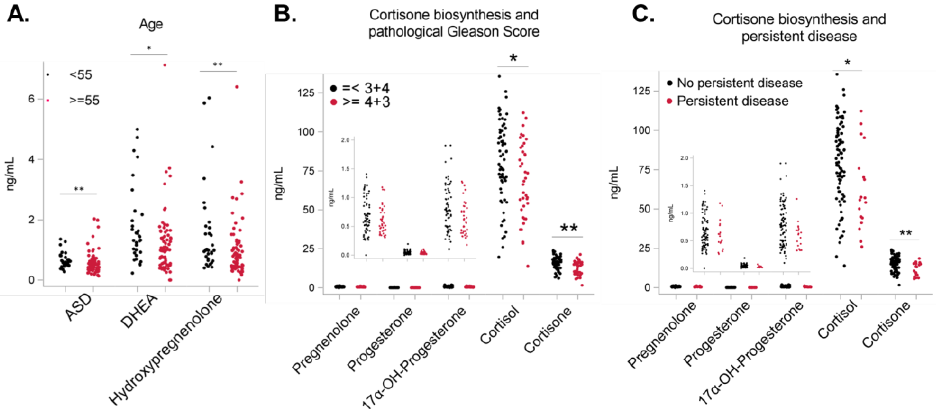
Figure 2. Serum metabolite levels are associated with clinical cofactors. The metabolite levels within groups of clinical cofactors were compared using a left-censored version of the log-rank test. * p < 0.05, ** p < 0.01 upon comparisons of the mean values in each category. Each dot represents a single clinical serum sample. ( A ) The mean androstenedione (ASD), dehydroepiandrosterone (DHEA), and hydroxypregnonolone serum levels are significantly higher in men <55 years than in men >=55 years with prostate cancer. ( B , C ) The mean cortisol and cortisone serum levels are lower in men with a prostate cancer Gleason Score >= 4 + 3 and persistent disease. The insets in each panel have alternate Y-axis to accurately depict the distribution of pregnenolone and 17- α